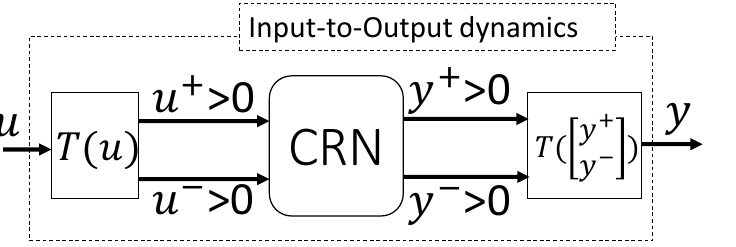
Figure 6. The depiction of input-to-output dynamics of a nonlinear internal positive representation using a linear system, given by the MAK of a